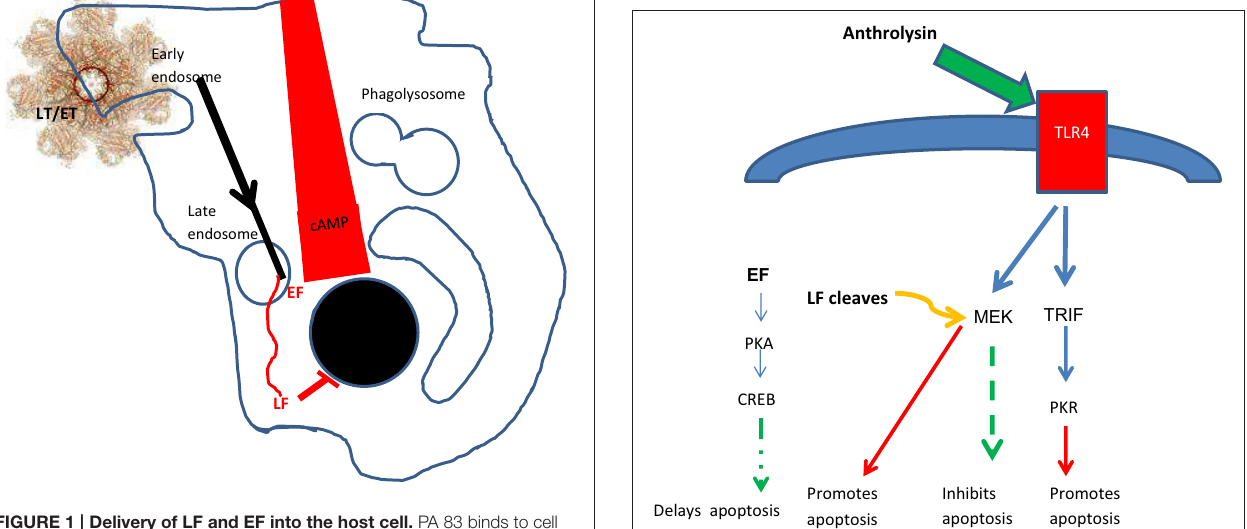
FIGURE 1 | Delivery of LF and EF into the host cell. PA 83 binds to cell surface receptors and is subsequently cleaved and oligomerises to form a heptamer (PA 7mer ). LF and EF can bind to the PA 7mer to form lethal toxin (LT) or edema toxin (ET) which associate with lipid rafts. These complexes are endocytosed (in clathrin-coated pits, facilitated by LRP6) and enter early endosomes. Subsequently, LT/ET are conveyed in vesicles to late perinuclear endosomes. The PA 7mer forms a pore in the vesicle luminal wall, releasing EF to the membrane and LF to the cytosol. EF creates a gradient of cAMP emanating from the nucleus to the cell wall, whilst LF cleaves the MAP/ERK kinase (MEK) substrate to inhibit nuclear protein synthesis. Glossary: MAPKKs, mitogen-activated protein kinase kinases; ERKK, extracellular-signal-regulated kinases; MEK, MAP/ERK kinases.